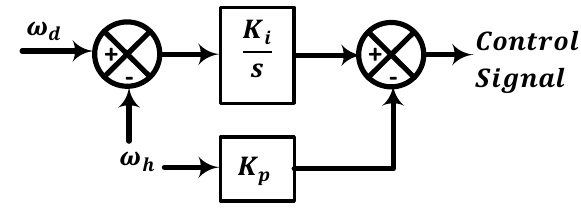
Figure 6. Integral and proportional controller structure.